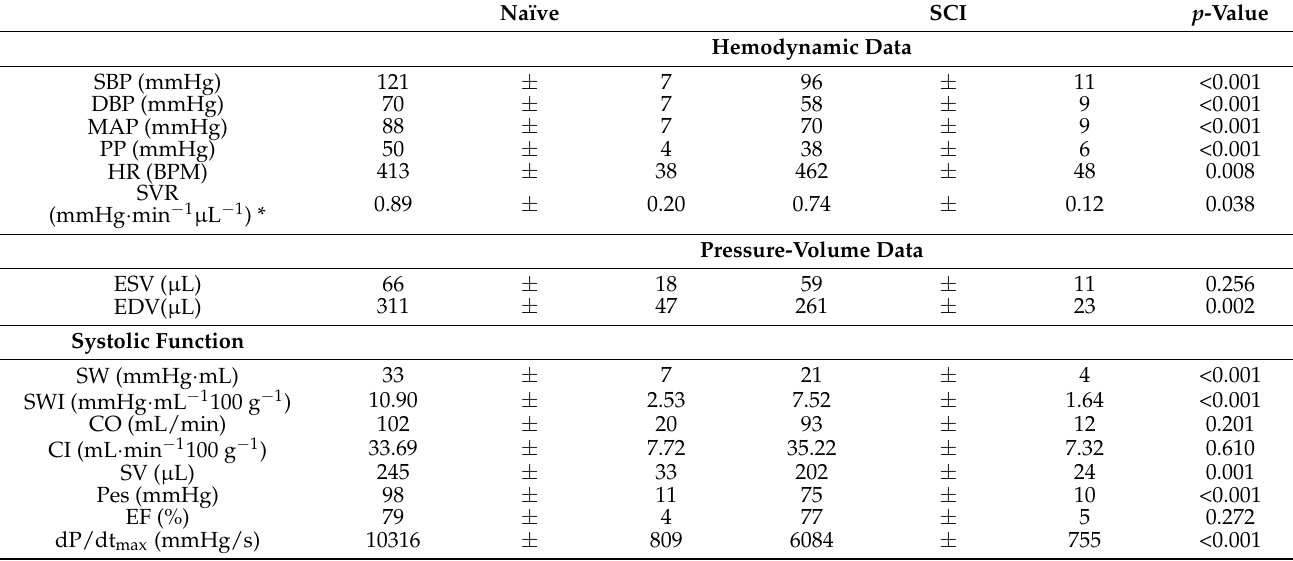
Table 1. Anthropometric, hemodynamic and pressure-volume data for 2-week post T3 300 kdyn SCI and naïve rats. Naïve SCI p